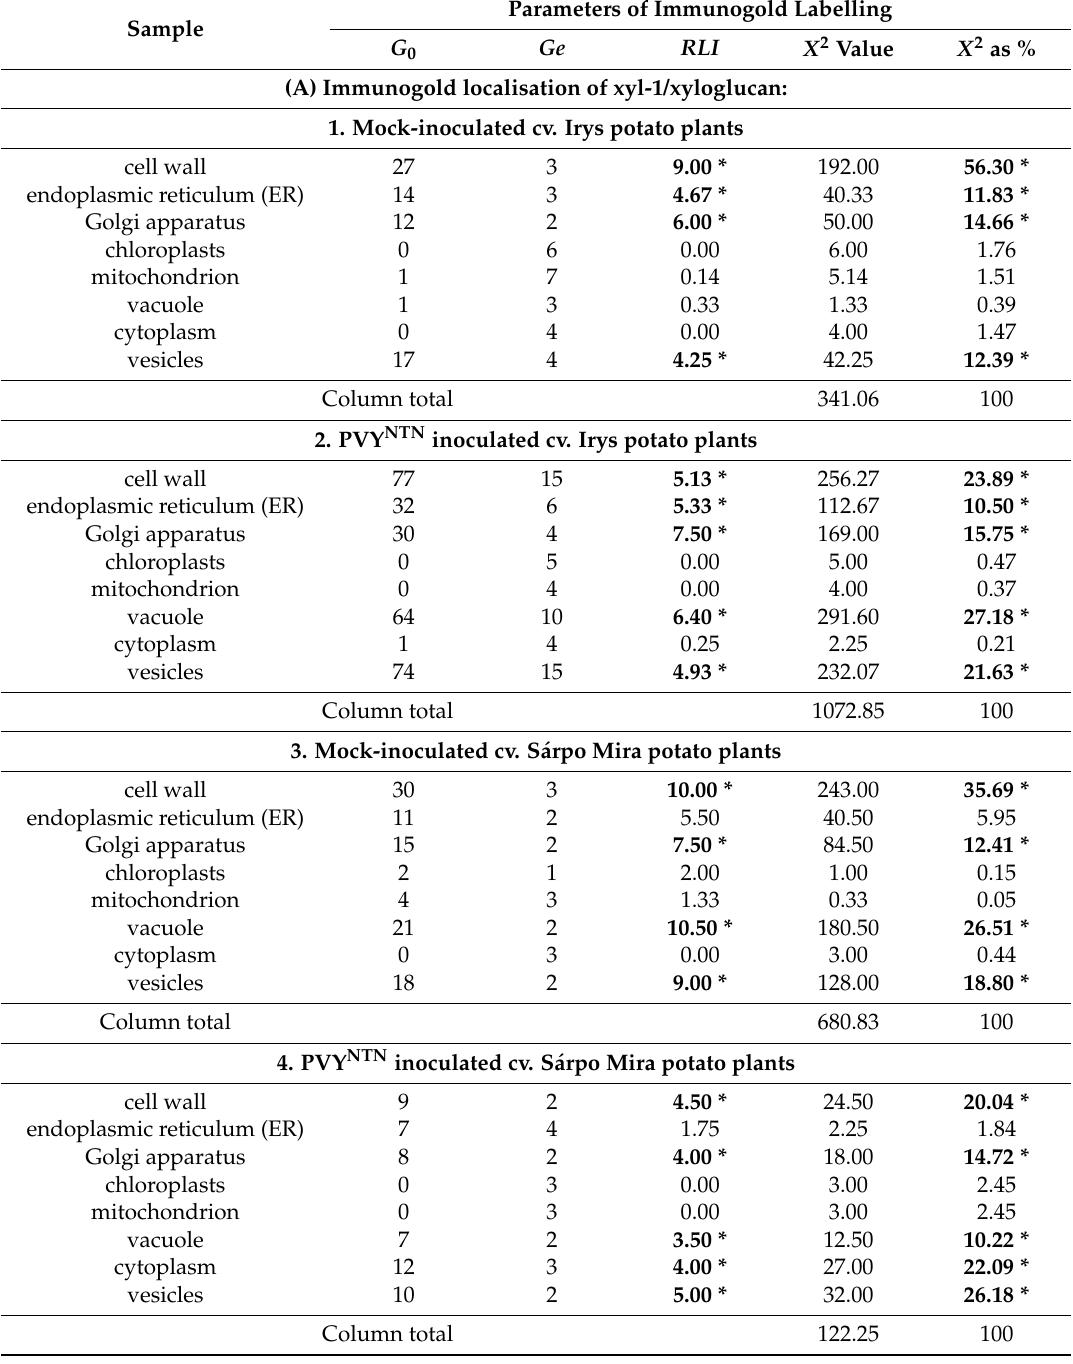
Table 1. Quantification of immunogold labelling by RLI and X 2 test of Xyl and XTH. ( A ) Assessment of immunogold labeling of xyl-1/xyloglucan in mock-inoculated and PVY NTN inoculated cv. Irys (susceptible) and cv. S á rpo Mira (resistant) potato plants. ( B ) Assessment of immunogold labelling of XTH-Xet5 in mock-inoculated and PVY NTN -inoculated cv. Irys (susceptible) and cv. S á rpo Mira (resistant) potato plants. Significant values (RLI > 1, and % X 2 at least 10%) in red bold font and marked with the asterisk